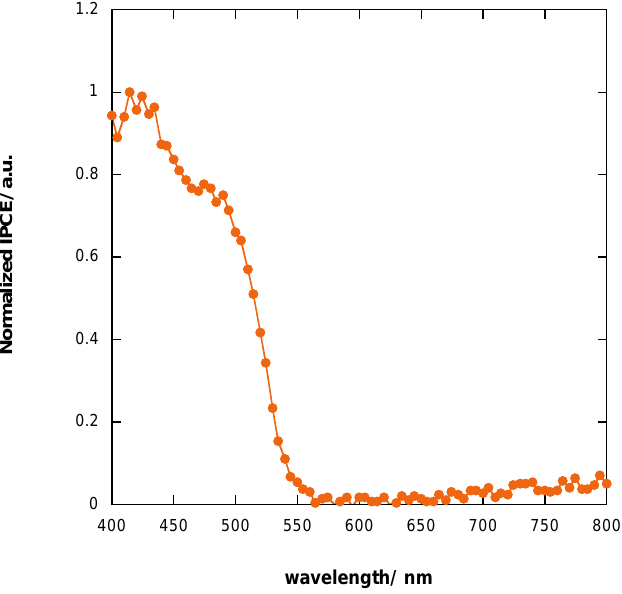
Figure 13. IPCE curve of photoelectrochemical cell.